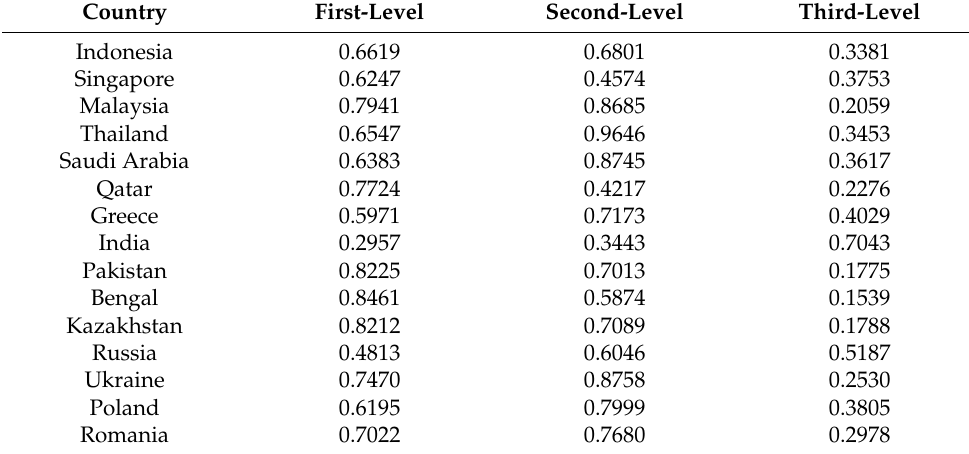
Table 7. Relative membership degree.